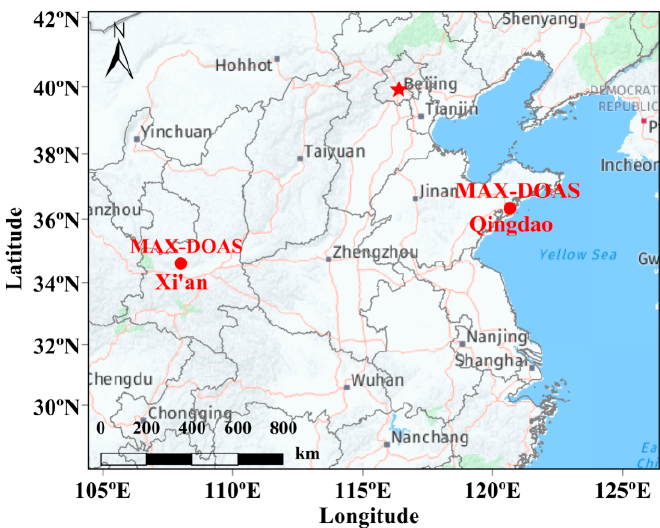
Figure 2. MAX-DOAS regional site location (the red circles).